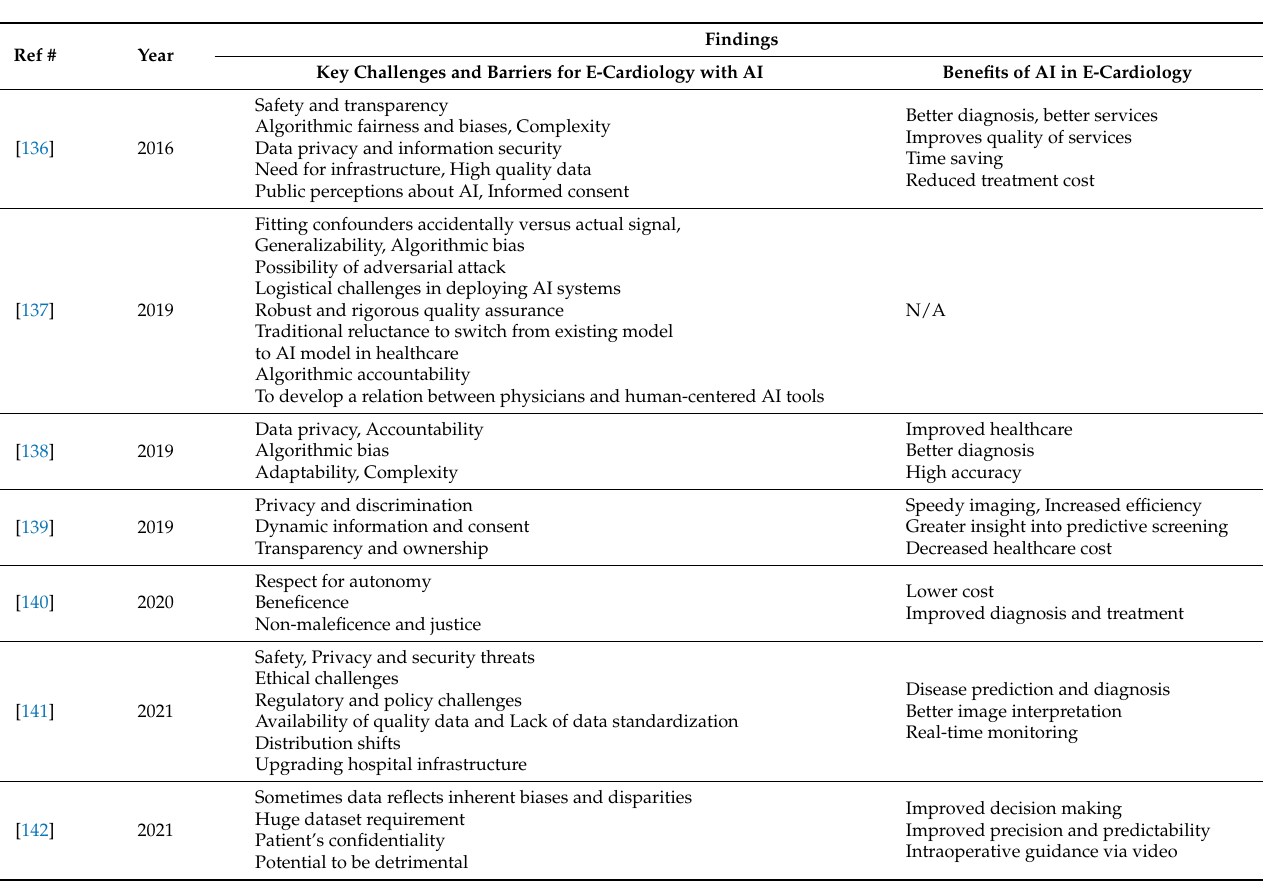
Table 17. Key challenges and primary benefits of AI-based